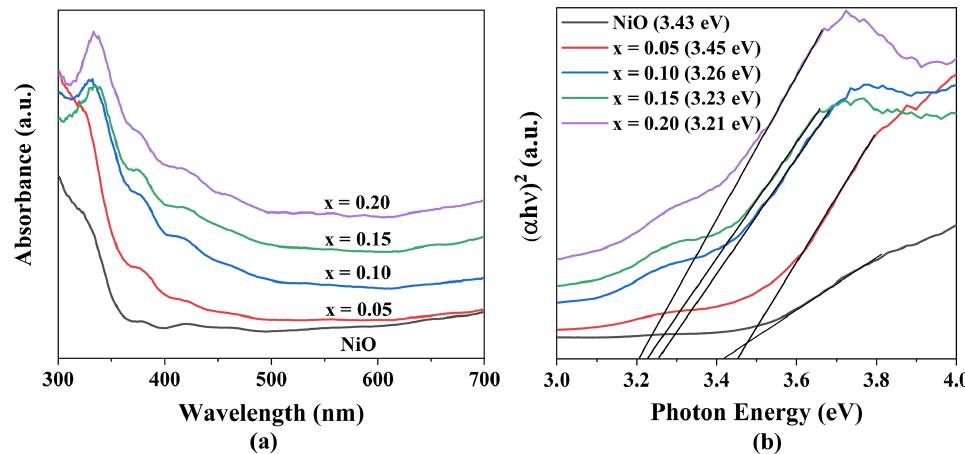
Figure 5. (a) Absorption spectra and (b) optical band gap spectra of pure NiO and samples with various K concentrations.